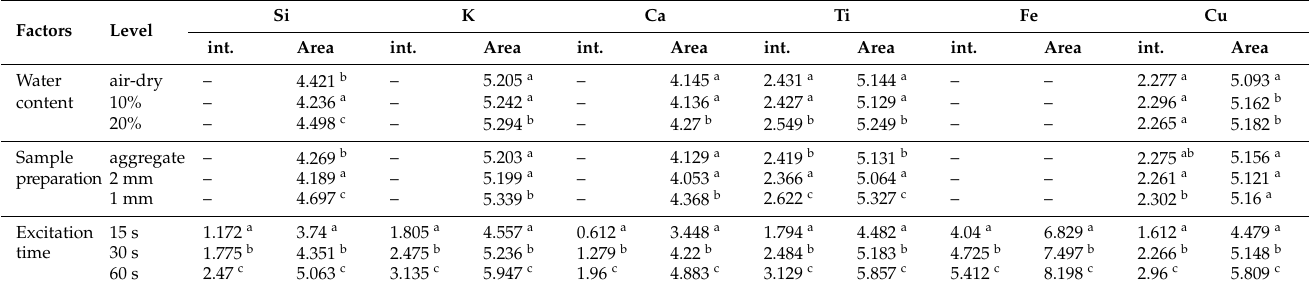
Table 5. Results of post hoc tests used to establish whether main effects of sample preparations, water content and excitation times affected XRF spectral